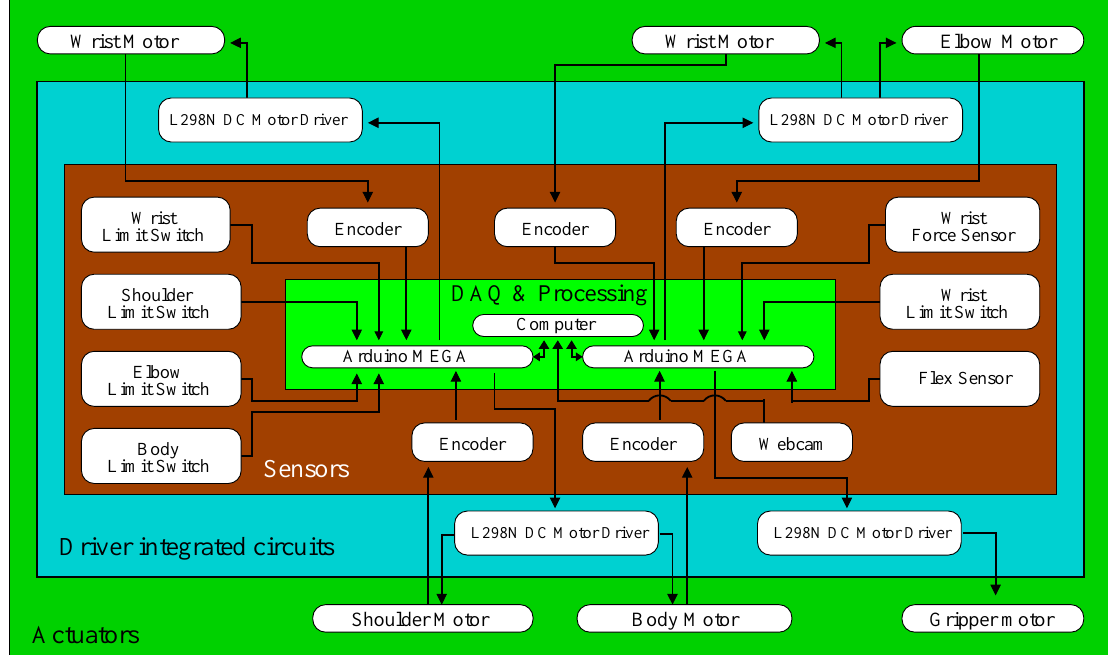
Figure 1. Robot architecture.